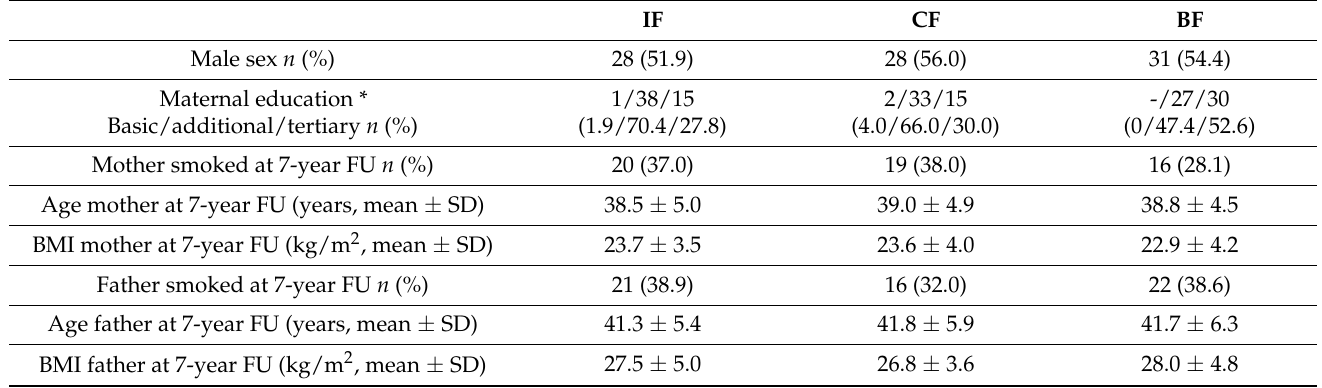
Table 1. Description of the infants that participated in the 7-year follow-up (FU) stratified according to study groups: intervention formula (IF), control formula (CF) and breastfed